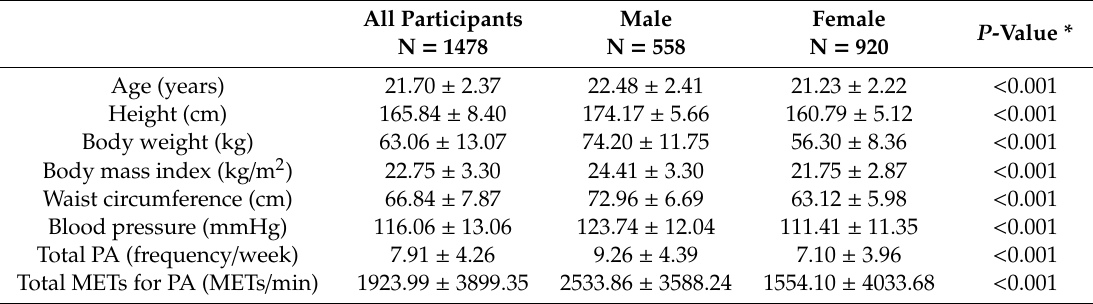
Table 1. Demographic